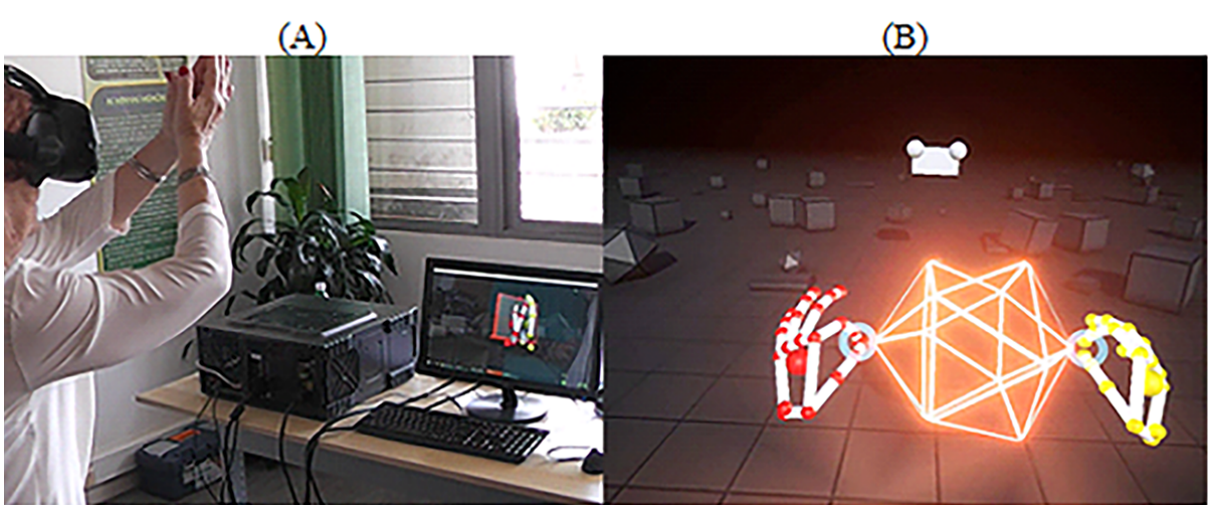
Figure 4. Blocks. (A) Manipulating geometrical figures using hands and head-mounted display with leap motion while standing. (B) Print screen of the game. A set of geometric figures that participants manipulate.